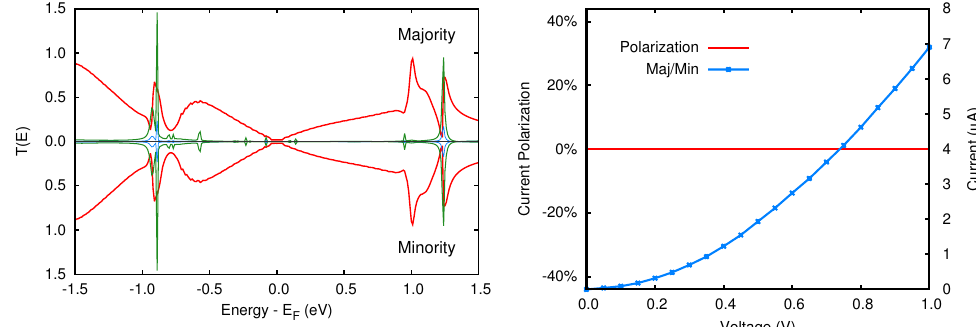
Figure 14. CO adsorbed junction. Left panel: spin-resolved transmission function at zero bias. The green line represents the density of states projected on both the CO molecule and iron atom, while the blue one only on the latter. Even if the system is non magnetic both spin components are shown for consistency. Right panel: spin-resolved electronic current and current